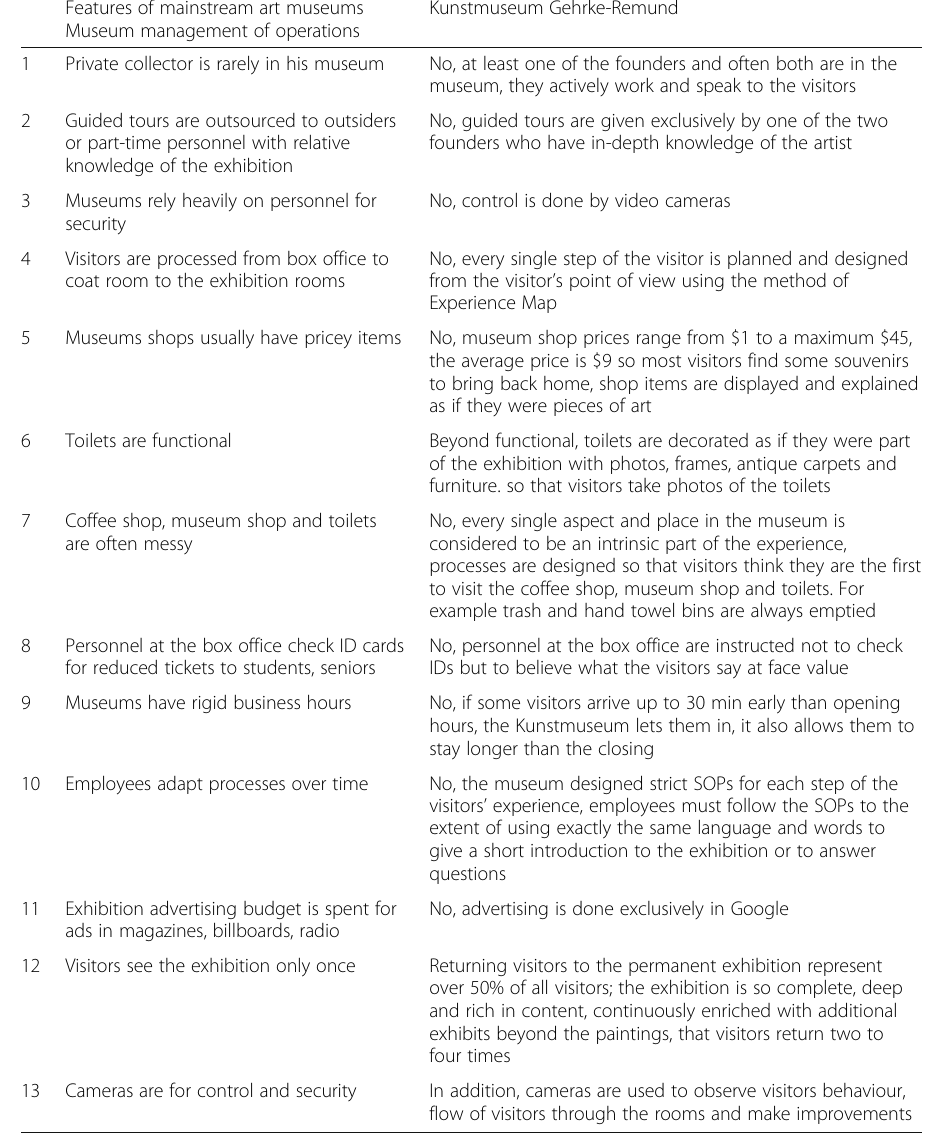
Table 2 Museum management and operations: comparison of features between mainstream art museums and the Kunstmuseum Gehrke-Remund. © 2008 Kunstmuseum Gehrke-Remund Features of mainstream art museums Museum management of